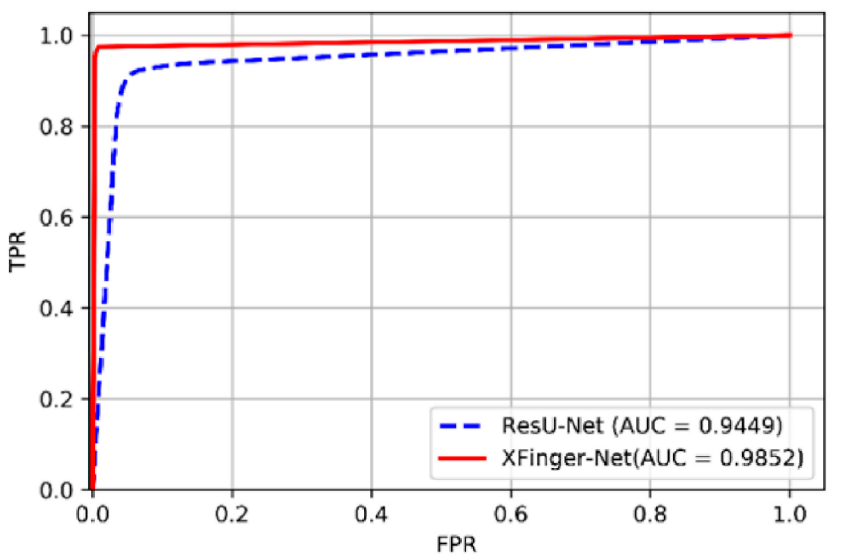
Figure 13. ROC curve of XFinger-Net and ResU-Net. Table 5. The score of the segmentation algorithm on test dataset.